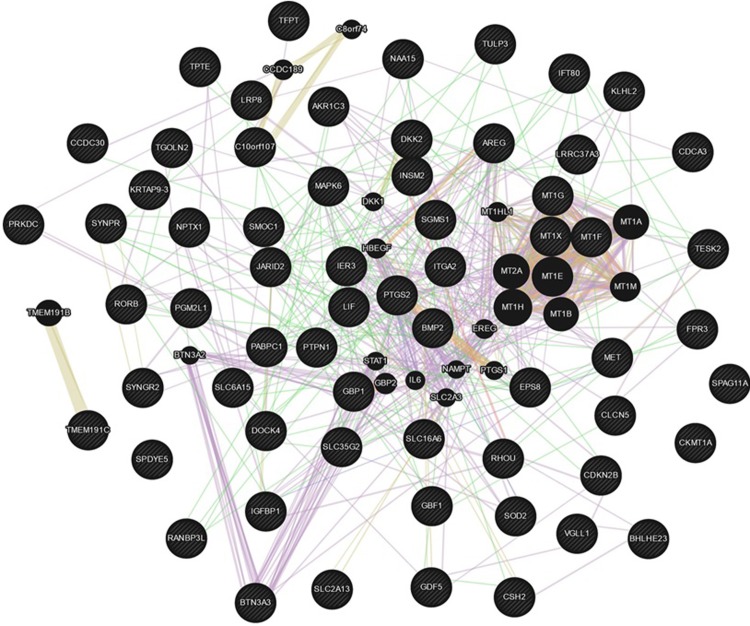
Functional interaction network from miR-320a-regulated genes plus the genes most related to the original list using GeneMANIA prediction server.